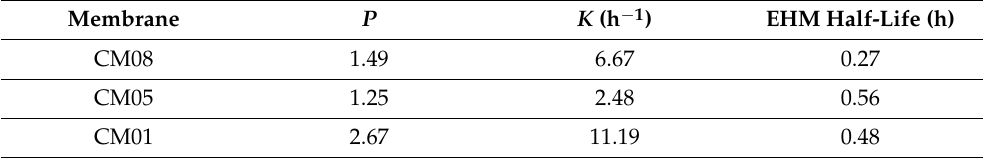
Table 4. EHM parameters for the regressions obtained in Example 2 for CM08, CM05, and CM01.